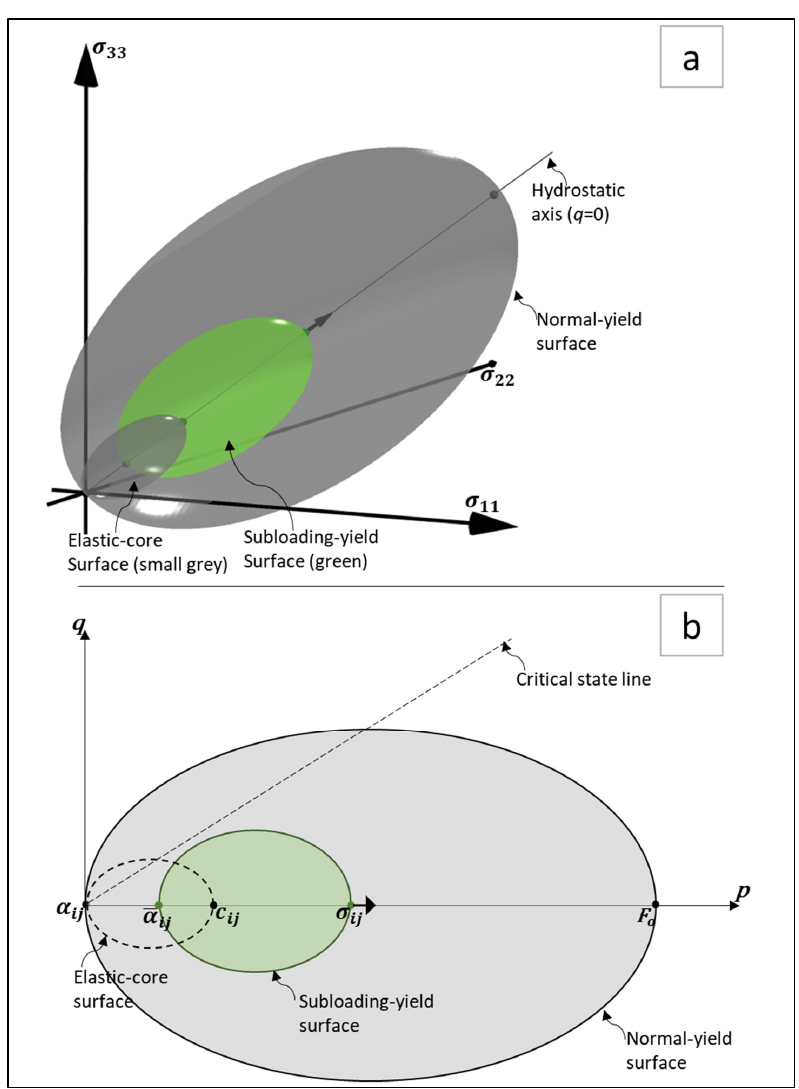
Figure 16. Normal yield, sub-loading yield and elastic core surfaces.